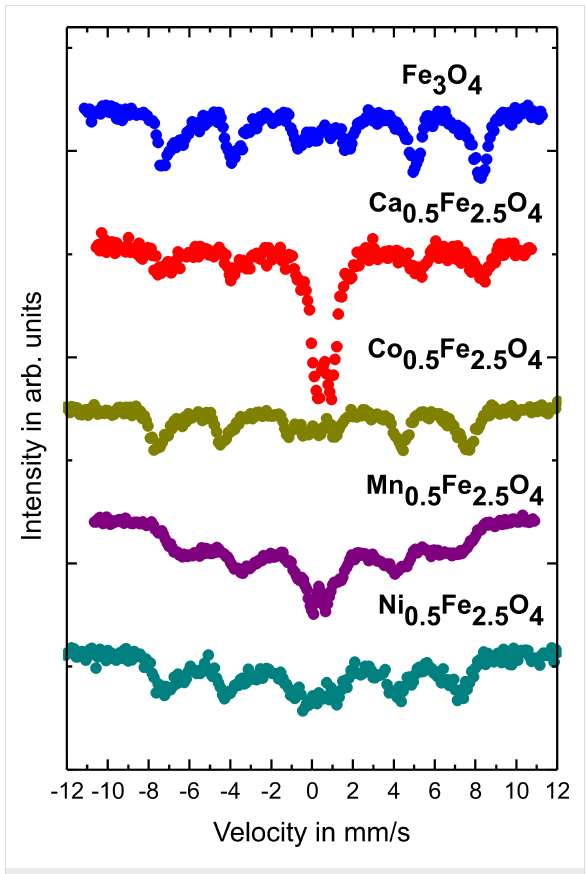
Figure 6: Mössbauer spectra of Fe 3 O 4 , Ca 0.5 Fe 2.5 O 4 , Co 0.5 Fe 2.5 O 4 , Mn 0.5 Fe 2.5 O 4 and Ni 0.5 Fe 2.5 O 4